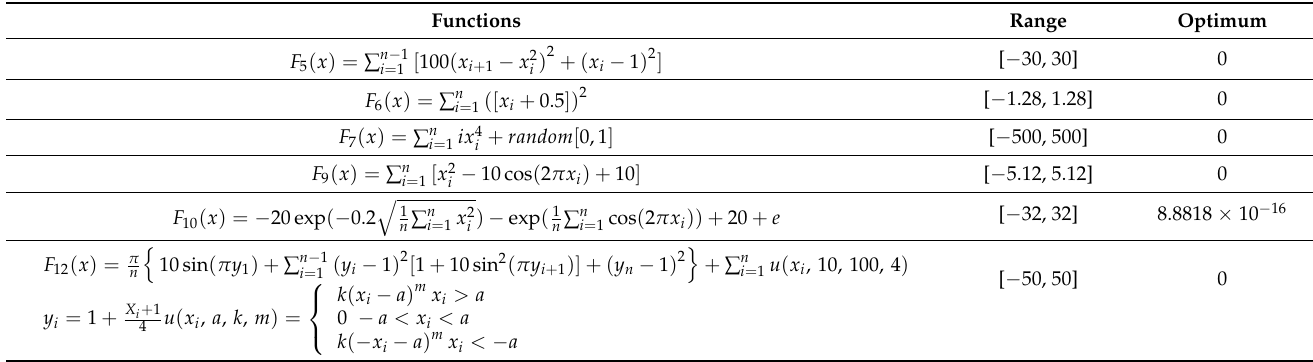
Table 2. Benchmark functions.